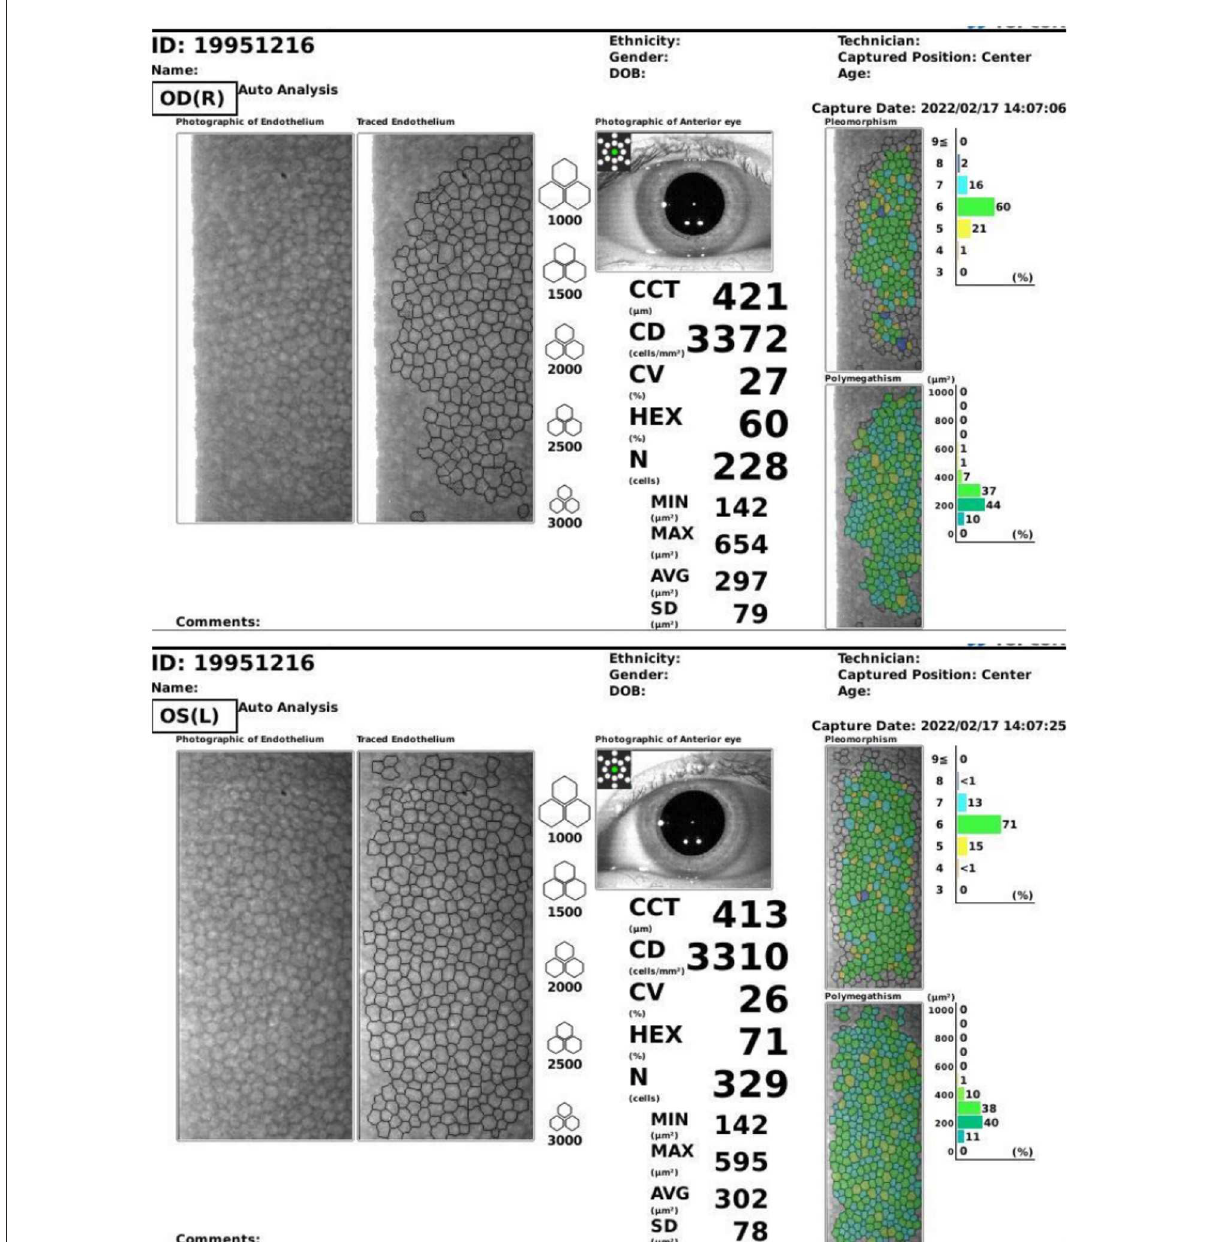
FIGURE3 Specular microscope of both eyes of the patient. The morphology and quantity of corneal endothelium in both eyes showed no